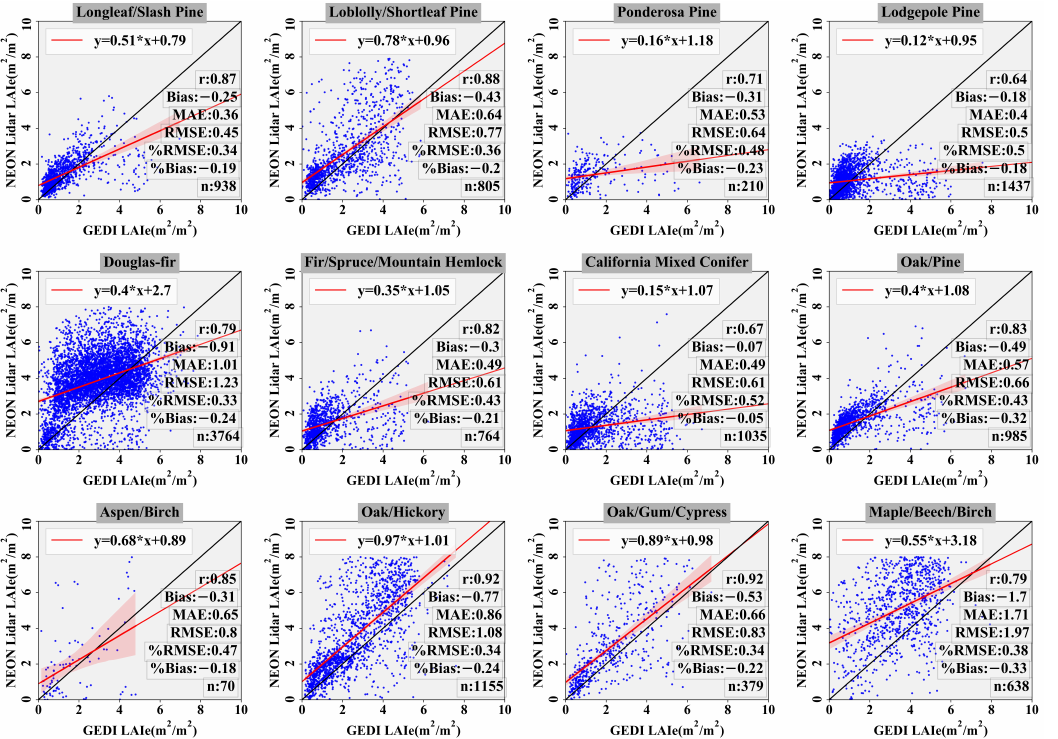
Figure 5. Comparison of LAIe between GEDI and NEON Lidar among forest types. Each scatter plot indicated a forest type with its name marked by a gray rectangle. The black and red solid lines are the 1:1 line and regression line, respectively.